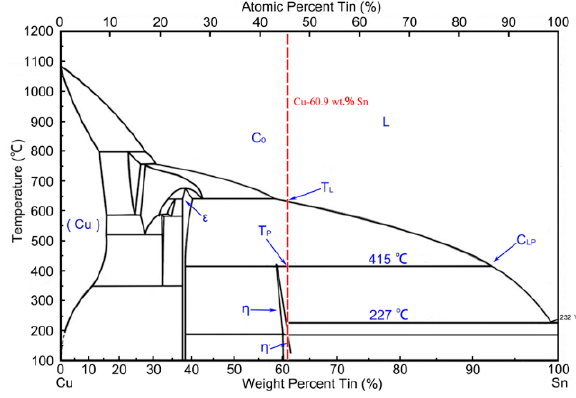
Figure 7. The Cu–Sn phase diagram [27].